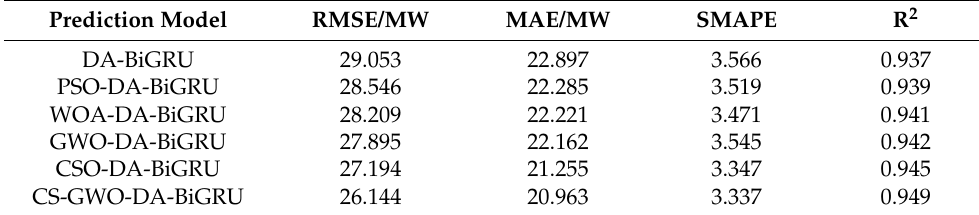
Table 5. The experiment results of case study